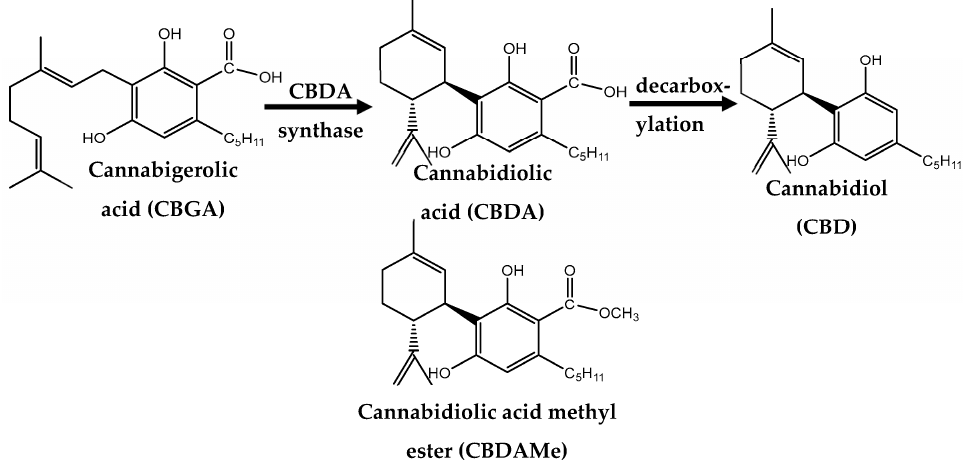
Figure 1. Conversion of cannabigerolic acid (CBGA), to cannabidiolic acid (CBDA), to cannabidiol (CBD) and CBDA stable analogue CBDA methyl ester (CBDA-ME) (ChemDraw Professional draw-